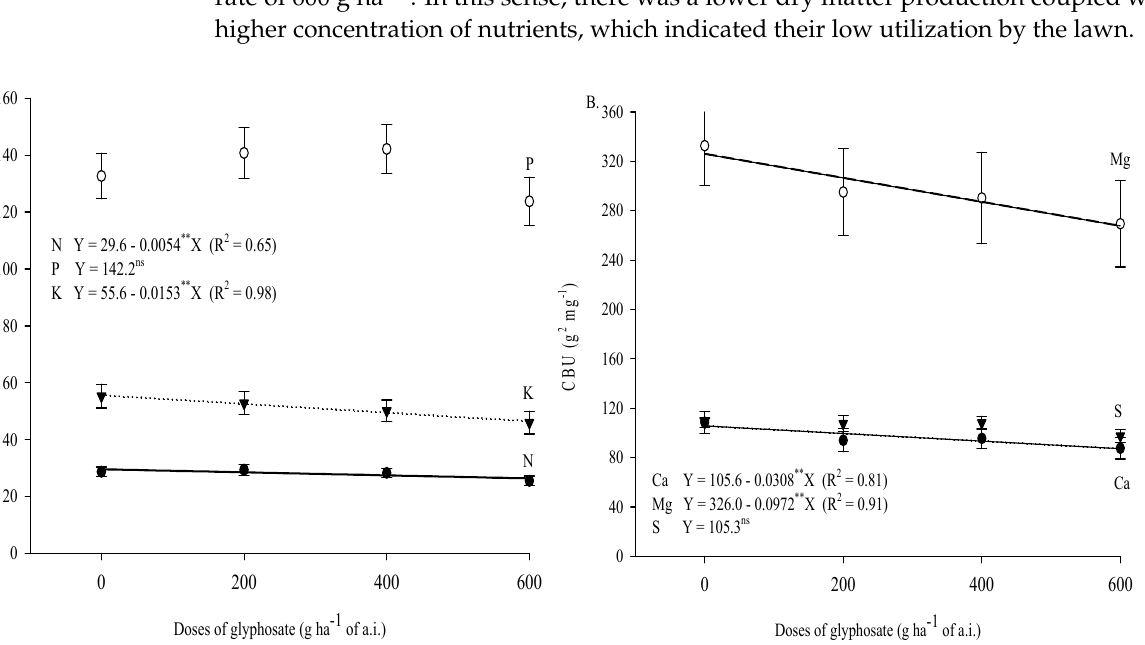
Table 4. The macronutrient balance obtained with the removal of leaves (“clippings “) and the ap ‐ plication of N, Ca and S to the emerald grass, according to its treatments with nitrogen fertilization and doses of glyphosate.